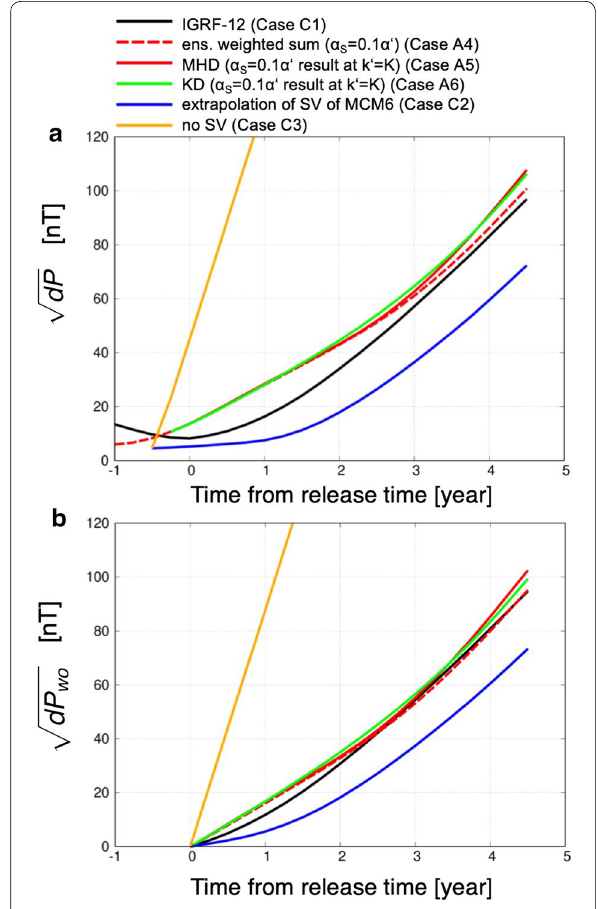
Fig. 8 Time evolutions of a √ d P (Eq. 40) and b √ d P wo (Eq. 41) from the release times, 2014.75 for our numerical experiments and 2015.00 for IGRF-12. Four results in a , Cases C1, A4, A5, and A6, are the same as the results in Fig. 6e. Newly added blue and orange lines indicate the extrapolation of SV at 2014.25 of the MCM6 model, and the case without SV from 2014.25, respectively. See Table 1 for the values of √ d P and √ d P wo 4.50 years after the release